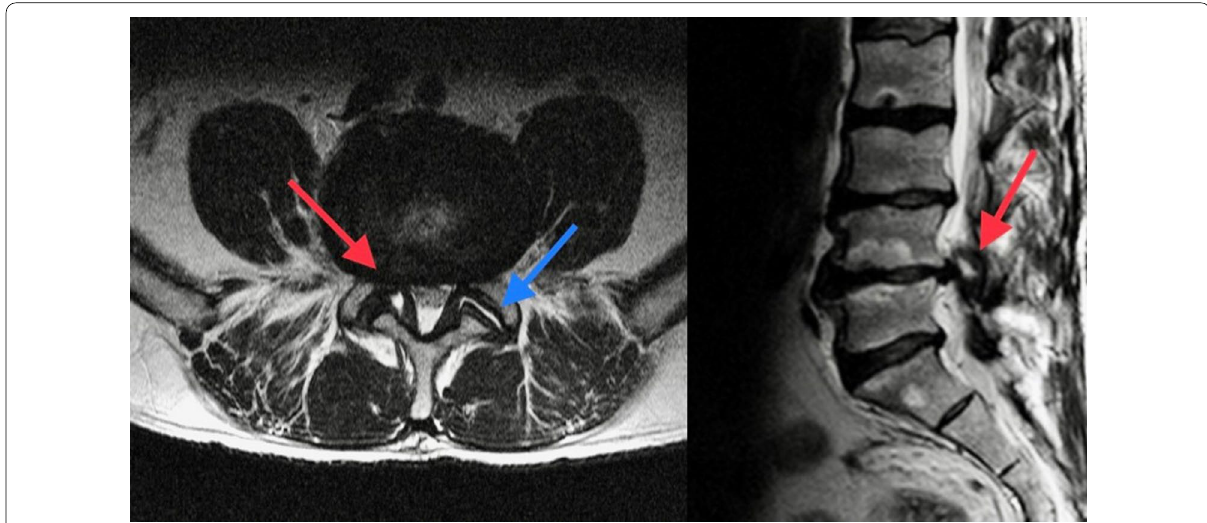
Fig. 4 Degenerative changes of the facet joints. Synovial cyst L4–L5 on the right (red arrow on axial and sagittal planes) with spinal canal expansion and lateral recess stenosis. Facet joint fluid collection on the